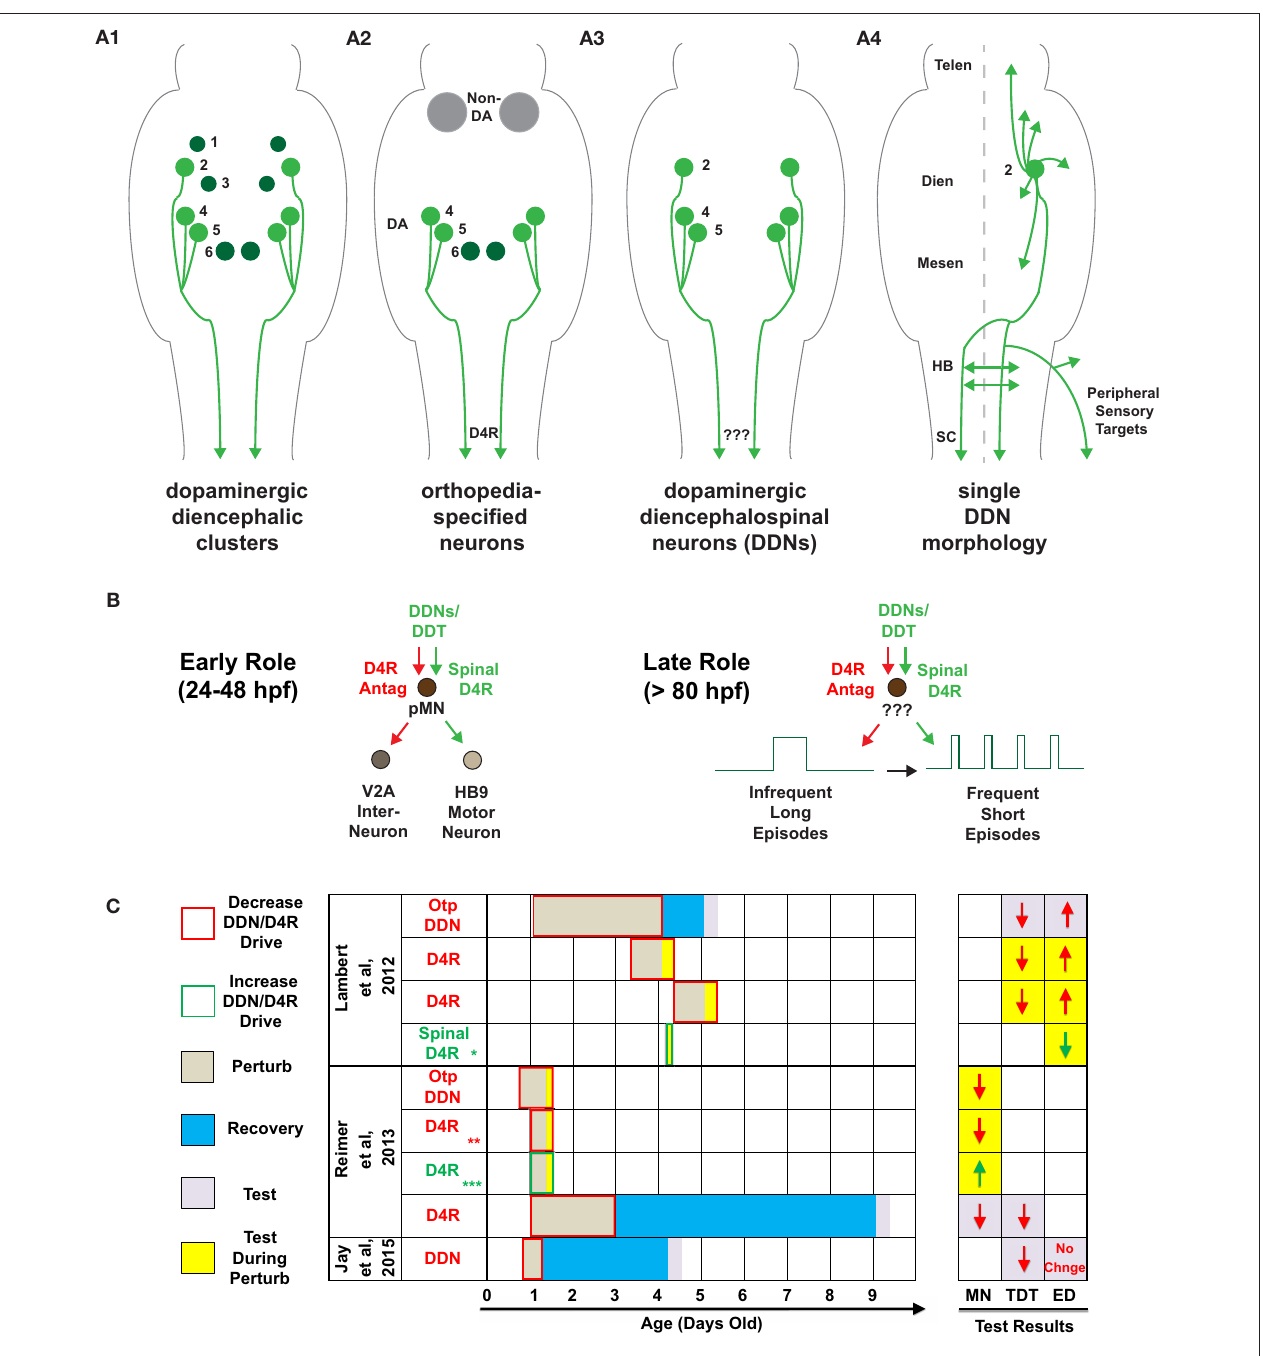
FIGURE 1 | Descending dopaminergic control of spinal network and locomotor development. (A) Schematics of dorsal views of the zebrafish brain and spinal cord, by 4-days-old, of: (A1) dopaminergic diencephalic clusters (DC) DC1-DC6. Note that DC2, DC4, and DC5 are the exclusive dopaminergic diencephalospinal neurons (DDNs) that comprise the dopaminergic diencephalospinal tract (DDT). (A2) orthopedia-specified neurons in the Tg(otpb.A:nfsB–egfp) zc 77 line used in Lambert et al. (2012), combined with systemic and localized dopamine receptor (DAR) pharmacology. (A3) DDNs targeted in Jay et al. (2015), but with no DAR pharmacology. (A4) single cell morphology of DC2 DDNs that tile virtually the entire rostrocaudal central neuraxis, as well as the peripheral sensory targets of the otic capsule, lateral line, and head and trunk neuromasts. (B) Putative model of the role of DDN-spinal D4R signaling in: ( B , left) spinal neuron